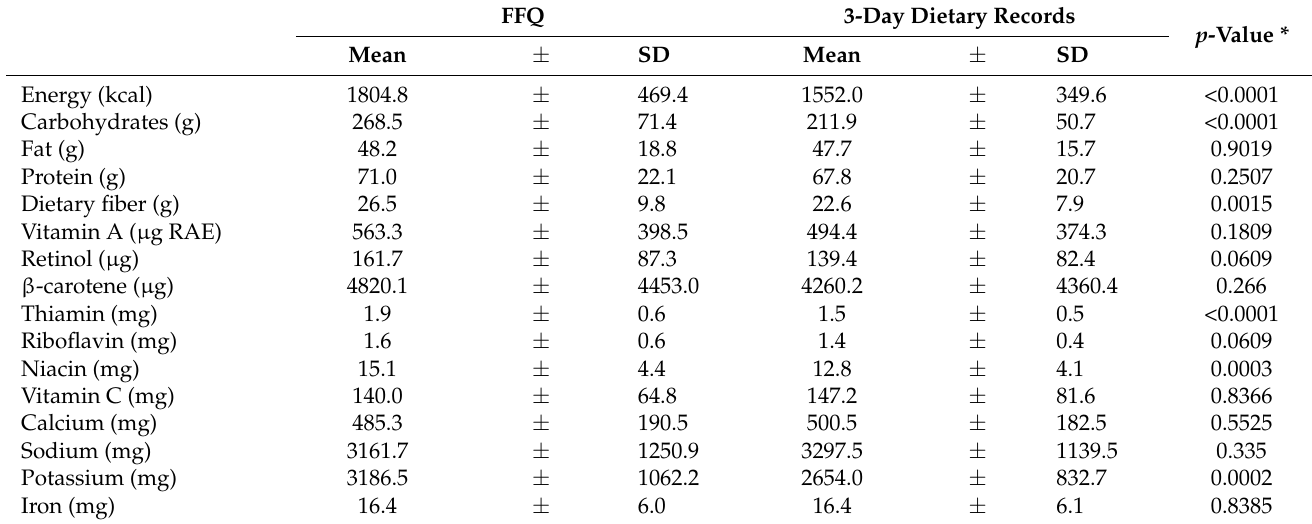
Table 4. Comparison of nutrient intake using FFQ and 3-day dietary records ( n = 100). FFQ